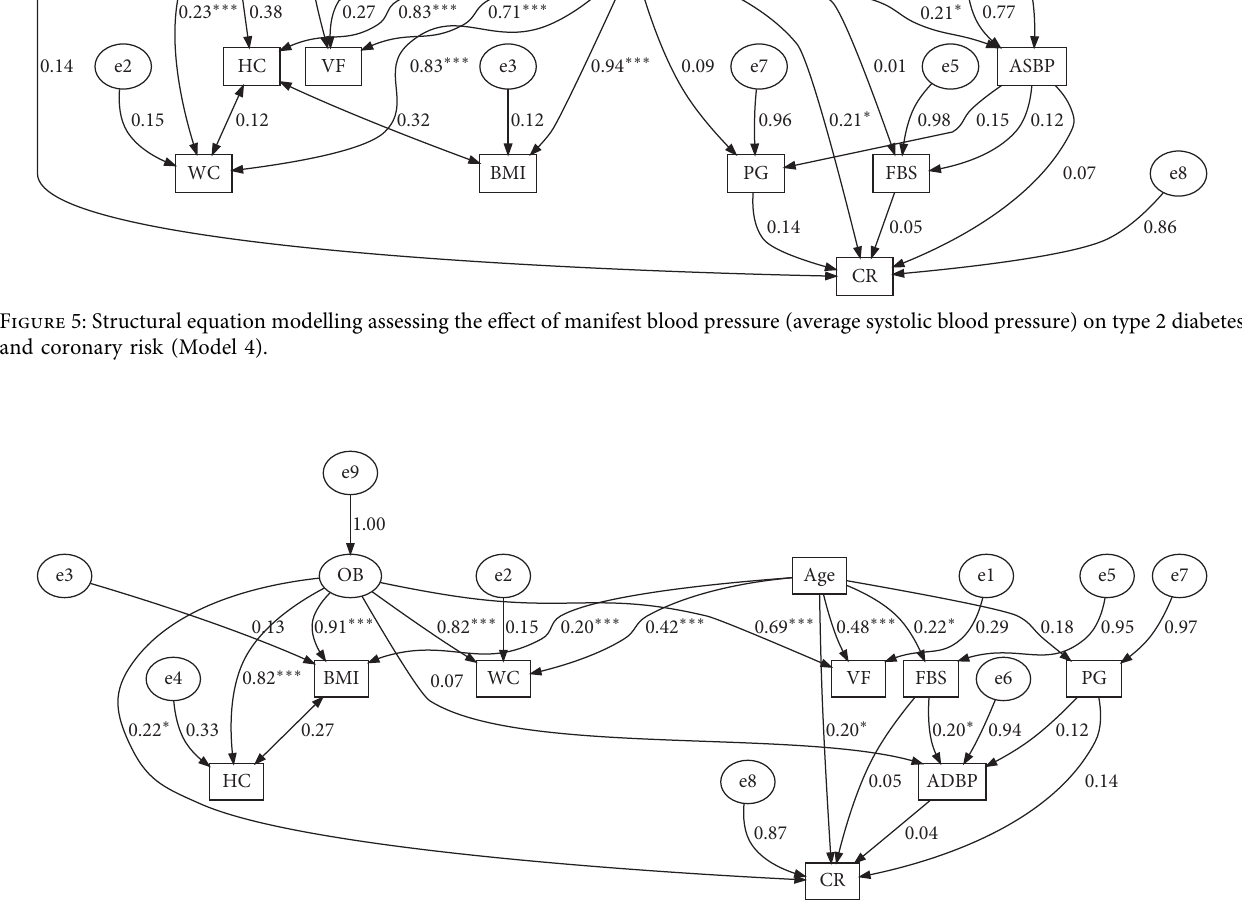
Figure 6: Structural equation modelling assessing the effect of type 2 diabetes on manifest blood pressure (average diastolic blood pressure) and coronary risk (Model